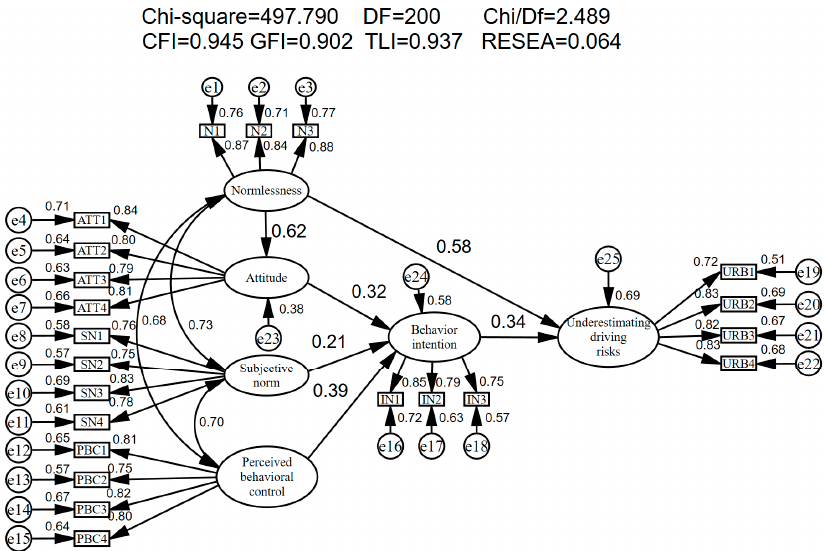
Figure 3. Modified model results.